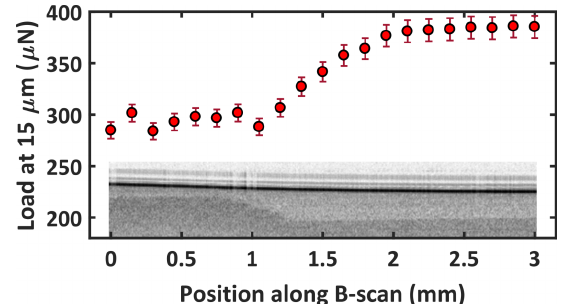
Fig. 5. Load applied to reach 15 (cid:1) m indentation depth, superimposed on the B -scan along which the measurements took place. The error bars are due to the error on the spring constant of the cantilever. The 21 measurements are 150 (cid:1) m apart, and they cover the 3 mm length of the B -scan. Load is calculated by multiplying the de°ection of the cantilever by its spring constant, quantities which are respectively measured by Fabri – Perot interferometry and by a calibration